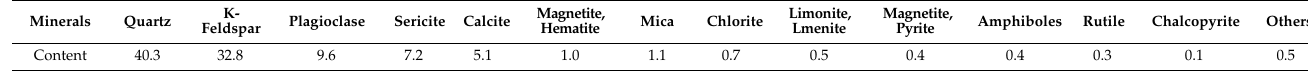
Figure 2. XRD pattern of quartz vein-hosted gold tailings samples. Table 4. Mineral compositions of the gold tailings (mass fraction,